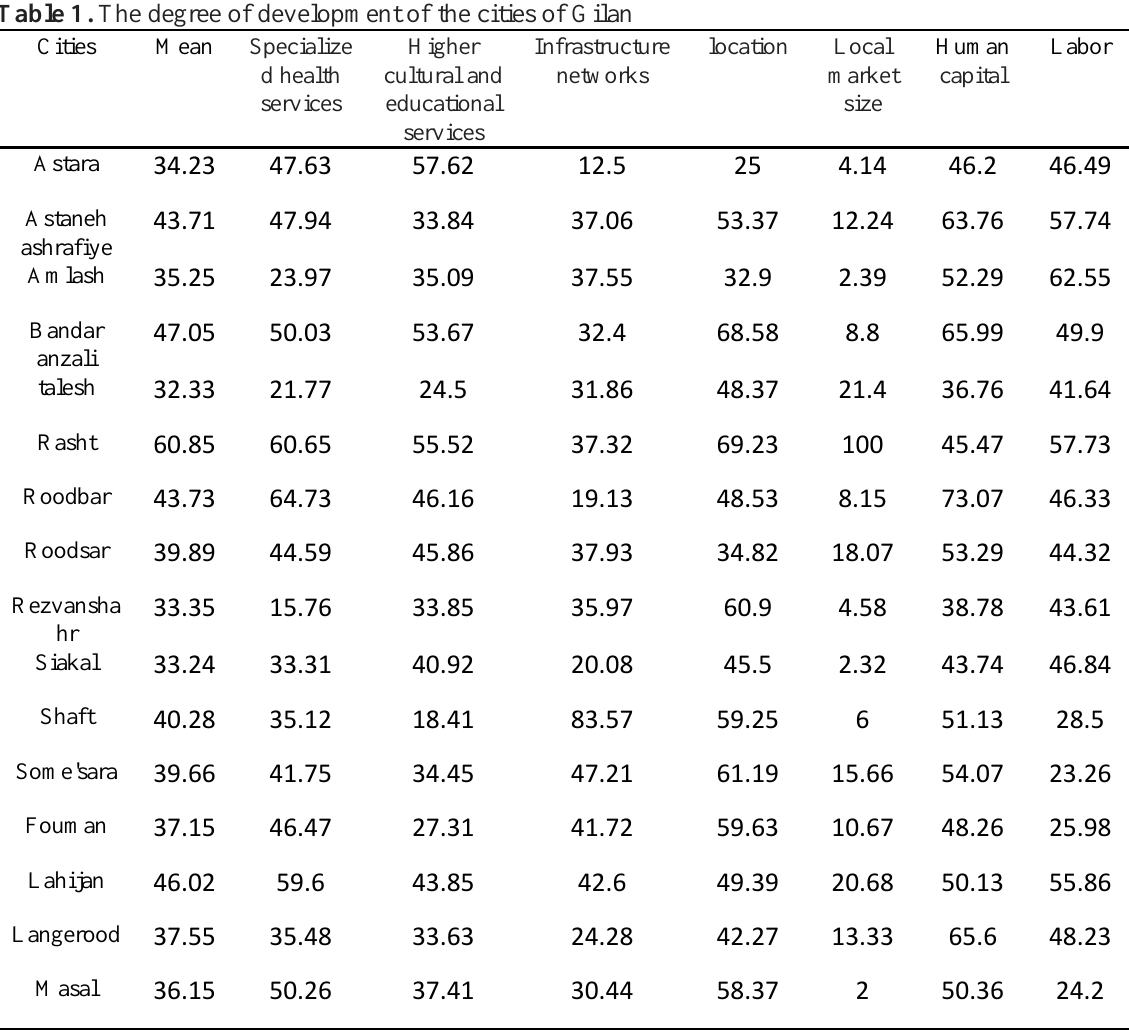
Table 1. The degree of development of the cities of Gilan